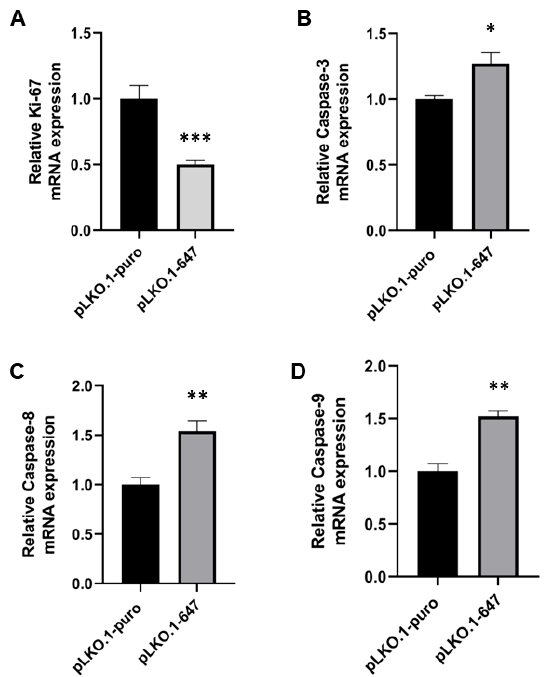
Figure 3. Real-Time PCR analysis of cell proliferation and apoptosis induction in HSC-3 cells, Figure 3. Real ‐ Time PCR analysis of cell proliferation and apoptosis induction in HSC ‐ 3 cells, following PON2 silencing. Expression of Ki ‐ 67 ( A ), Caspase ‐ 3 ( B ), ‐ 8 ( C ) and ‐ 9 ( D ) was evaluated following PON2 silencing. Expression of Ki-67 ( A ), Caspase-3 ( B ), -8 ( C ) and -9 ( D ) was evaluated in control (pLKO.1 ‐ puro) and PON2 downregulating (pLKO.1 ‐ 647) cells. Values are expressed as in control (pLKO.1-puro) and PON2 downregulating (pLKO.1-647) cells. Values are expressed as mean ± standard deviation (* p < 0.05; ** p < 0.01; *** p < 0.005). mean ± standard deviation (* p < 0.05; ** p < 0.01; *** p <